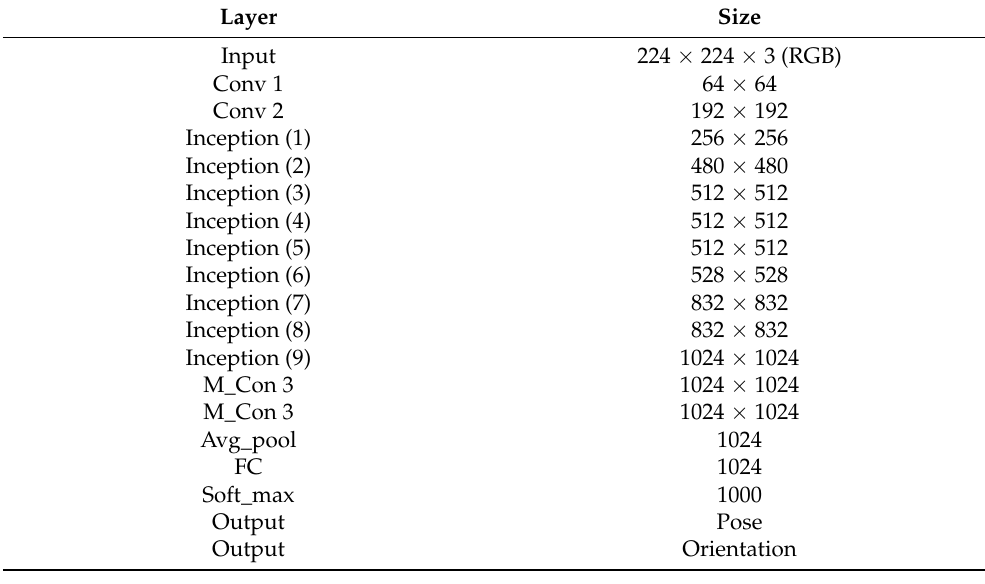
Table 1. Layer details of the proposed Y_PN-MSSD model.